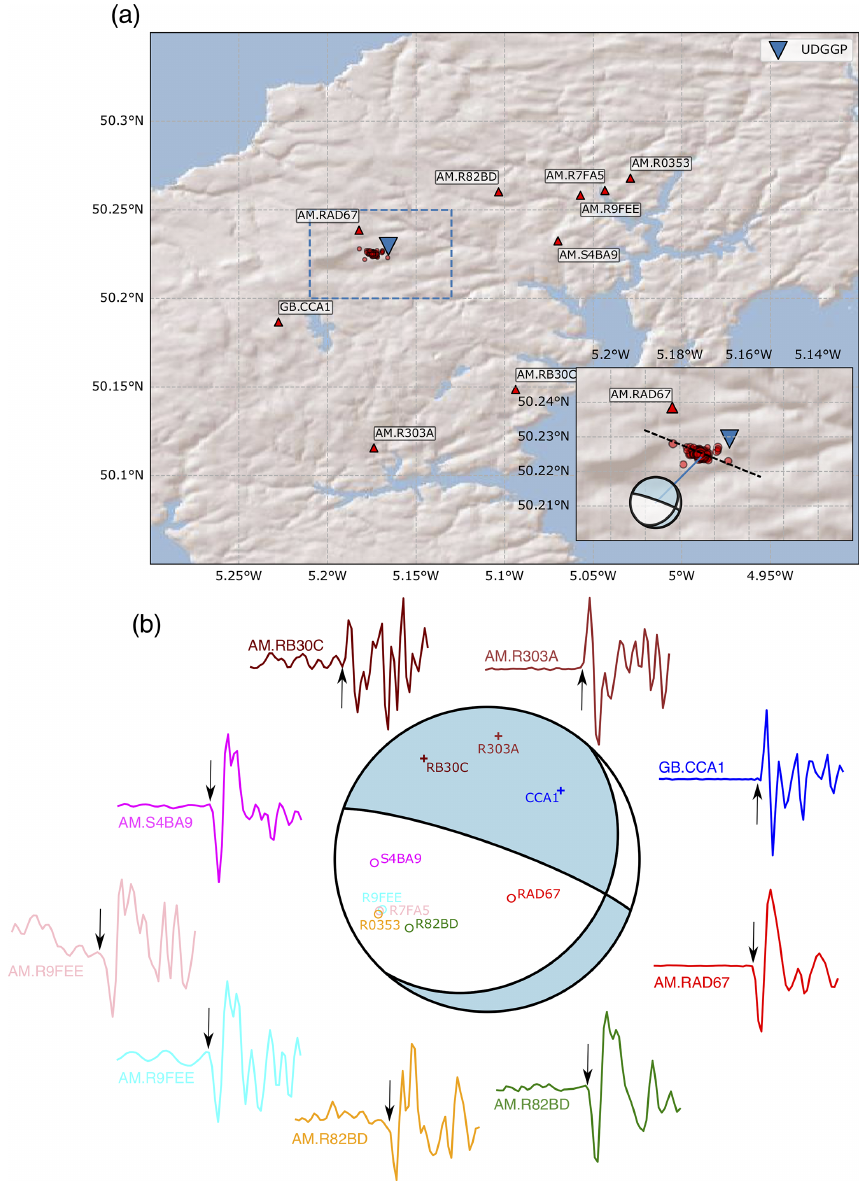
Figure 11. (a) Red triangles show Raspberry Shake (network code: AM) and BGS (network code: GB) seismic stations in Cornwall, with station names labelled. Seismicity during geothermal operations is indicated by red circles. The inset shows a close-up of the area demarcated by the dashed blue line in the main map. The dashed black line in the inset shows the broad WNW–ESE alignment in seismicity. (b) Computed focal mechanism for the 30 September 2020, 11:44:01UTC, M L 1.6 induced earthquake. First motions are plotted on the focal sphere with “ + ” indicating positive polarity and “o” showing negative polarities. P-wave first motions are plotted starting and ending 0.3s before and after the picked arrival, respectively, and are coloured in the same way as the points on the focal